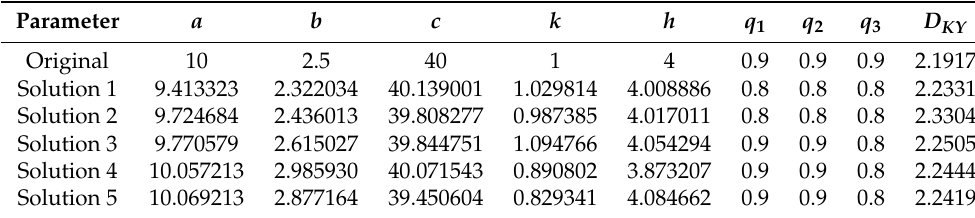
Table 2. Five solutions of the optimization of Liu system (4) applying